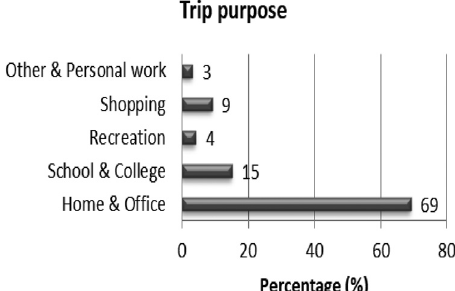
Figure 7. Purpose of trips